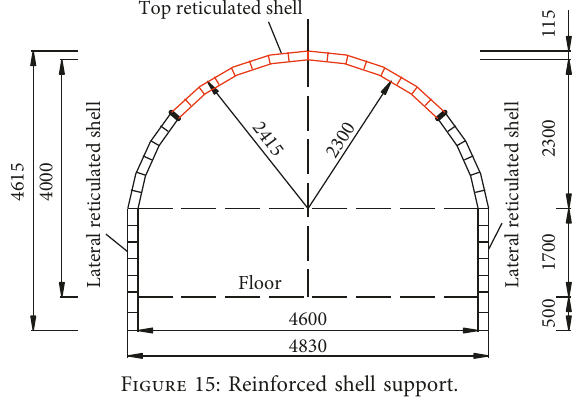
Figure 15: Reinforced shell support.